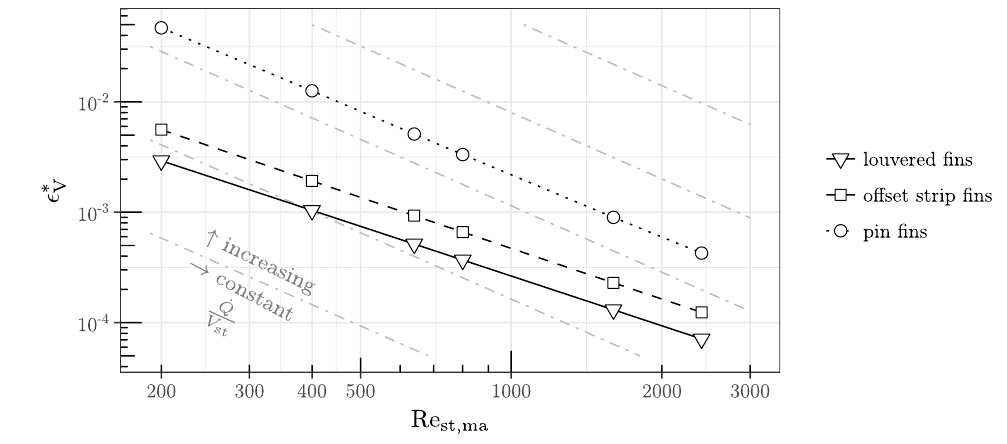
Figure 6. Non-dimensional volume efficiency (cid:101) ∗ versus Reynolds number Re st,ma for different V enhancements; standard comparison is at equal Reynolds number; grey dash-dot lines represent combinations of (cid:101) ∗ and Re st,ma with equal ˙ Q / V V